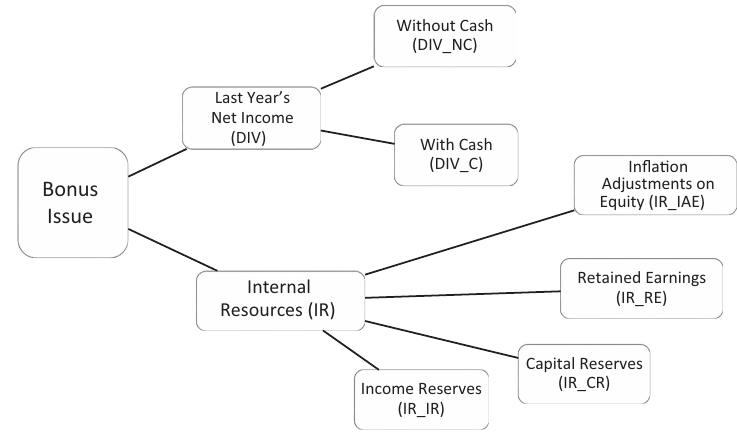
Figure 1. Types of bonus